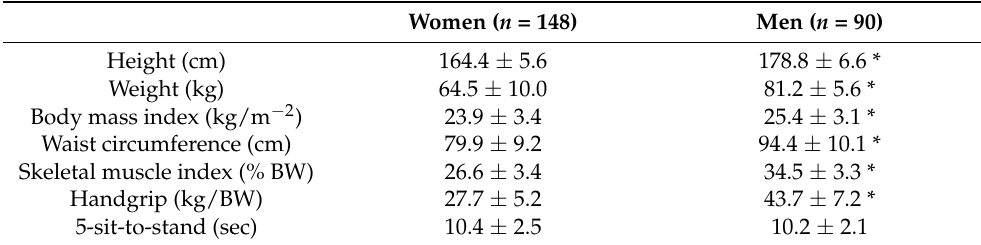
Table 1. Anthropometrics and indicators of muscle health.